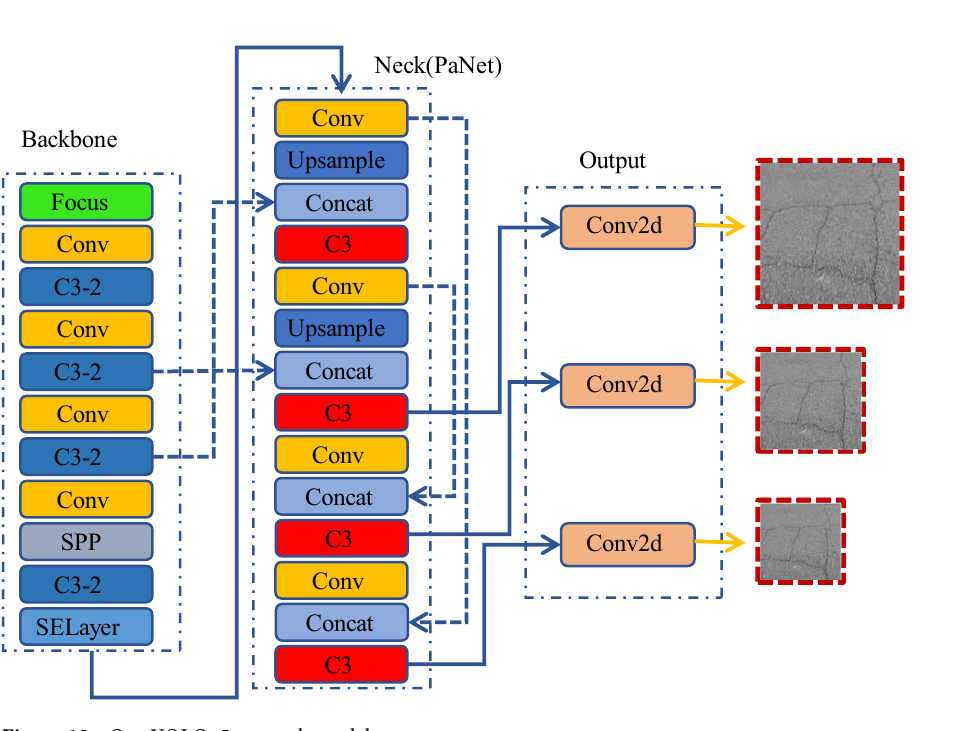
Figure 12. Our YOLOv5 network model